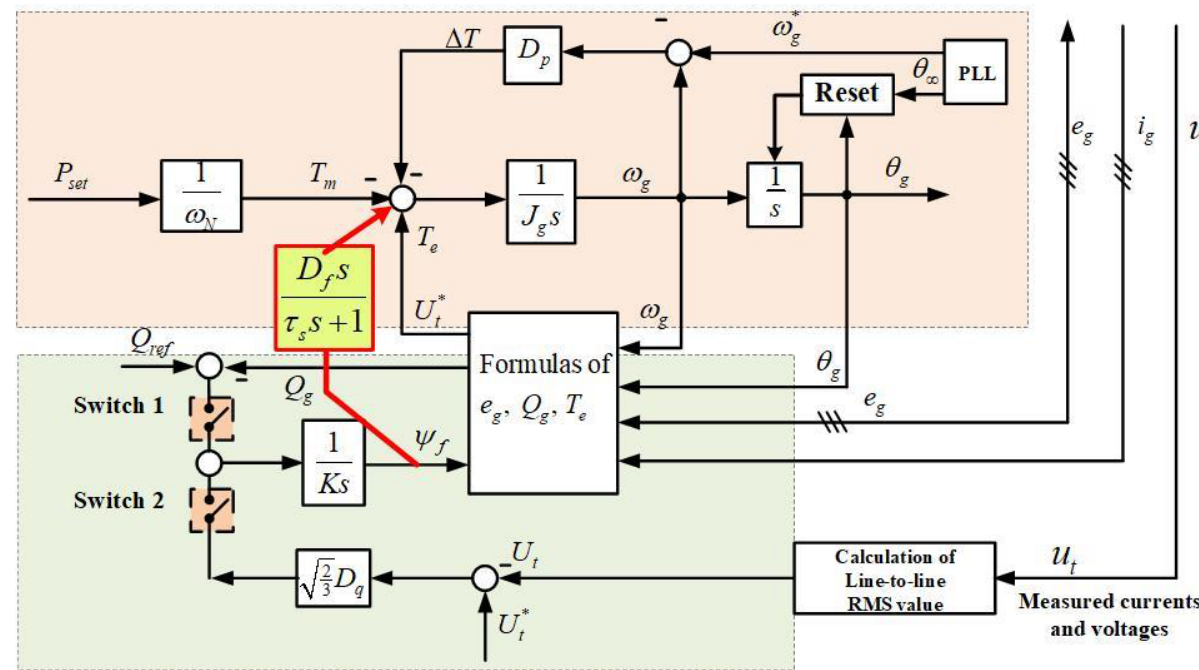
Figure 8. Proposed synchronverter controller with auxiliary correction loop.